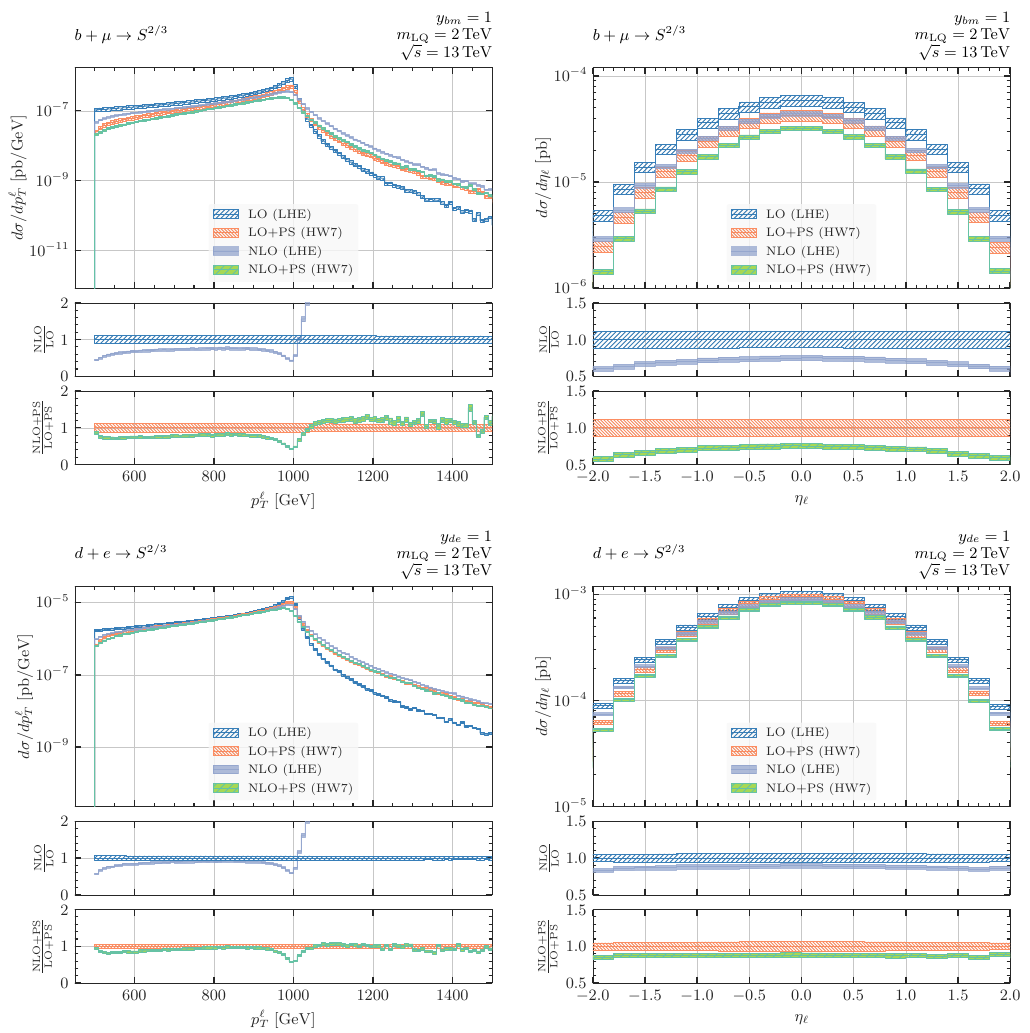
Figure 5 . The transverse momentum (left column) and the pseudorapidity (right column) distri- butions of the leading- p lepton. See section 3.2 for T